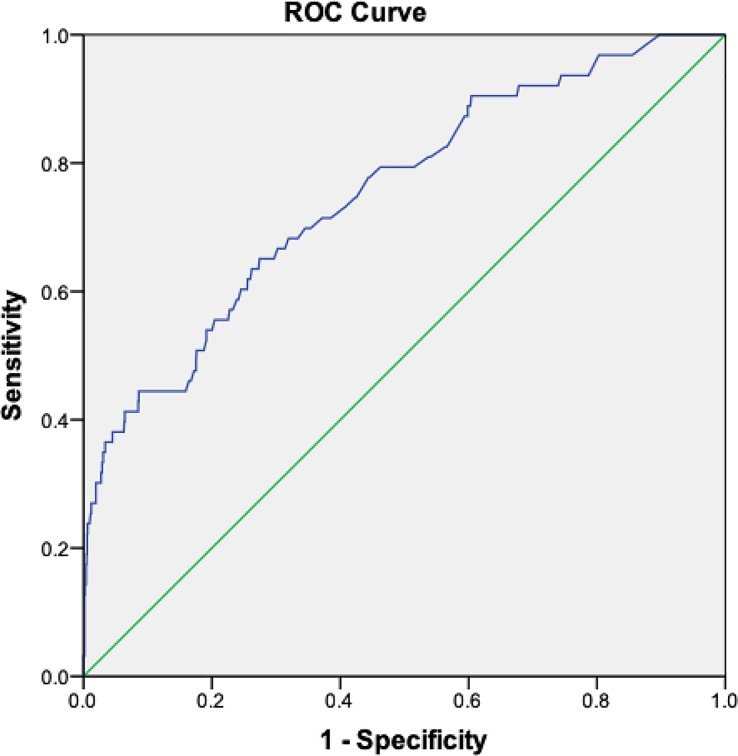
ROC curve analysis of multivariate regression model of AKI among dengue patients.